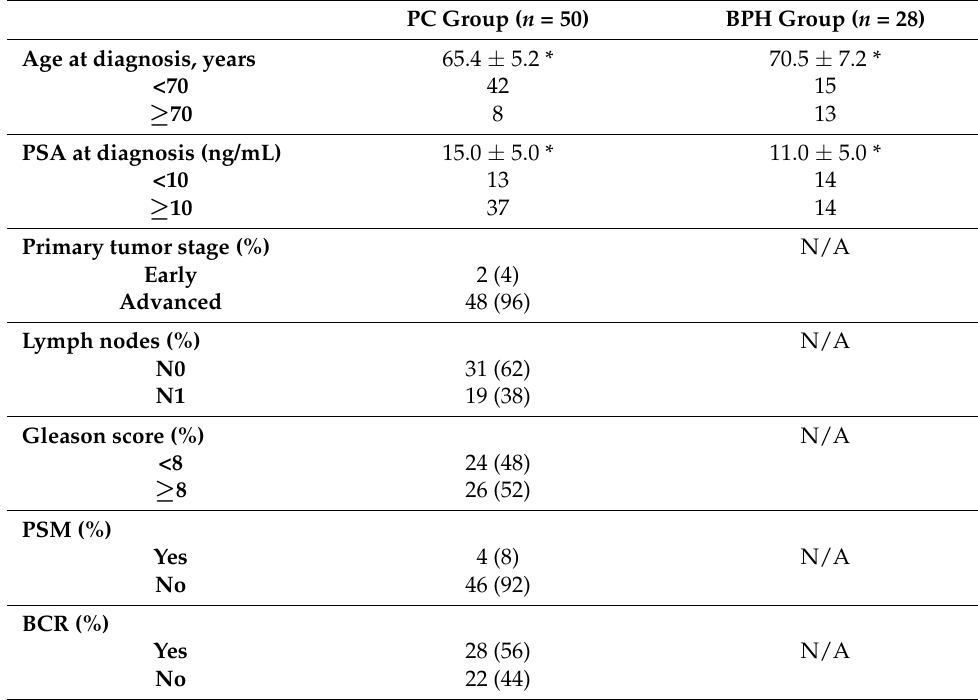
Table 1. Clinical characteristics of all participants in the